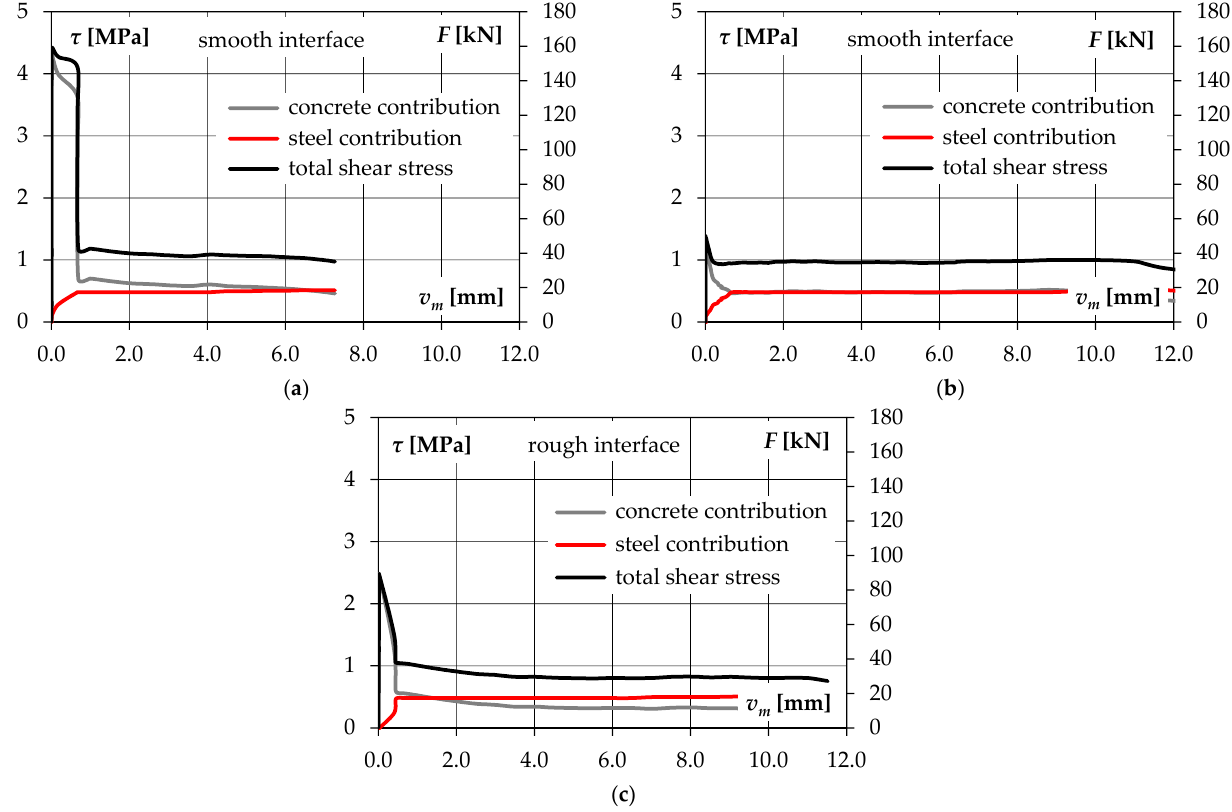
Figure 20. Shear transfer components as a function of interface slip: ( a ) L30/50-S-0.14, ( b ) L30/30-S-0.14, ( c ) L30/30-R-0.14.